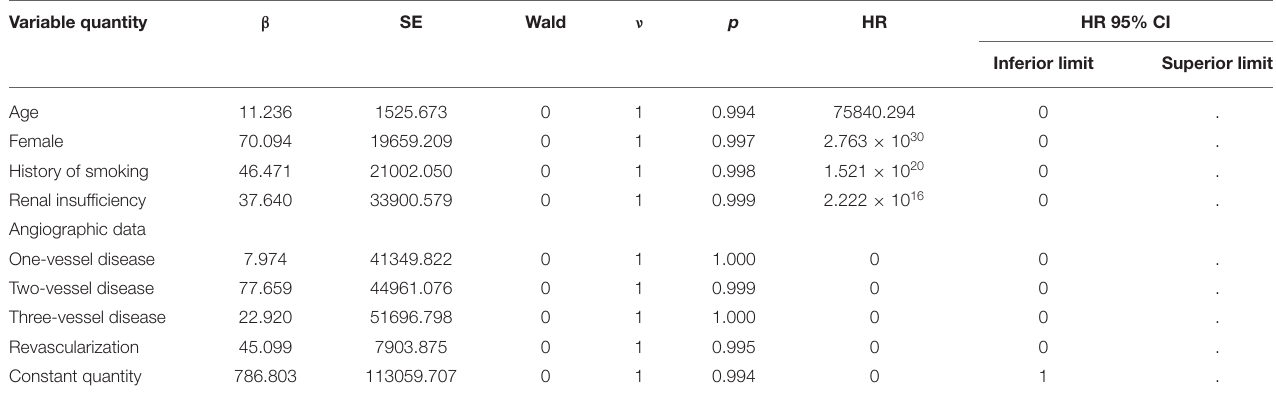
TABLE 3 | Logistic regression results of the prognosis of death in hospitalized patients. Variable quantity